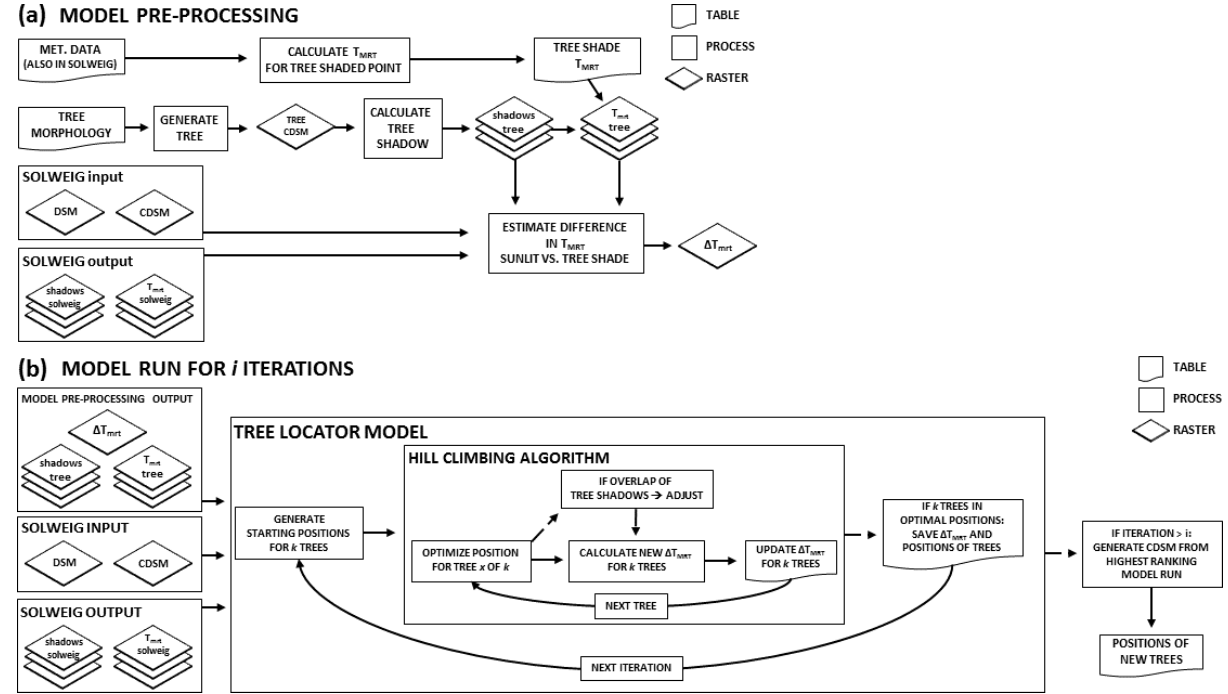
Figure 1. Flowchart of the model (a) showing the model pre-processing and (b) showing the optimization of tree locations. The flowchart consists of tables (e.g., tree morphology and meteorological data), processes (e.g., GENERATE TREE, which is an algorithm that generates a general 3-D tree form from input tree morphology table data) and raster grids. Some grids can have more than one layer, where each layer represents one time step (e.g., TREE SHADOW, where each layer represents shadow pattern for a specific time step). The end product is a table with the positions of the